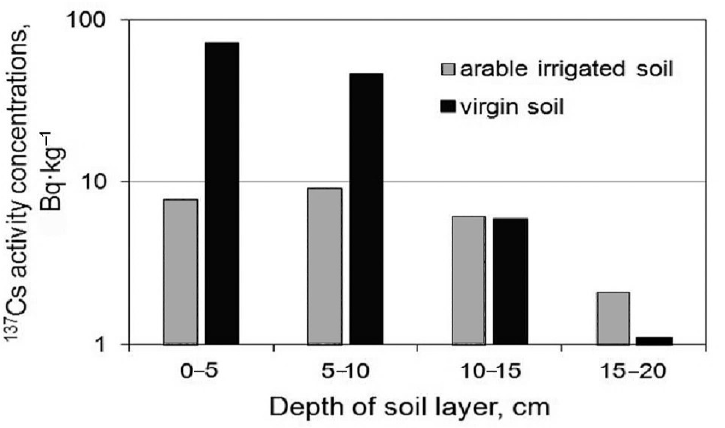
Figure 11. Vertical distribution of the 137 Cs activity concentration in the irrigated soil (d.w.) under Medicago sativa and in the virgin soil